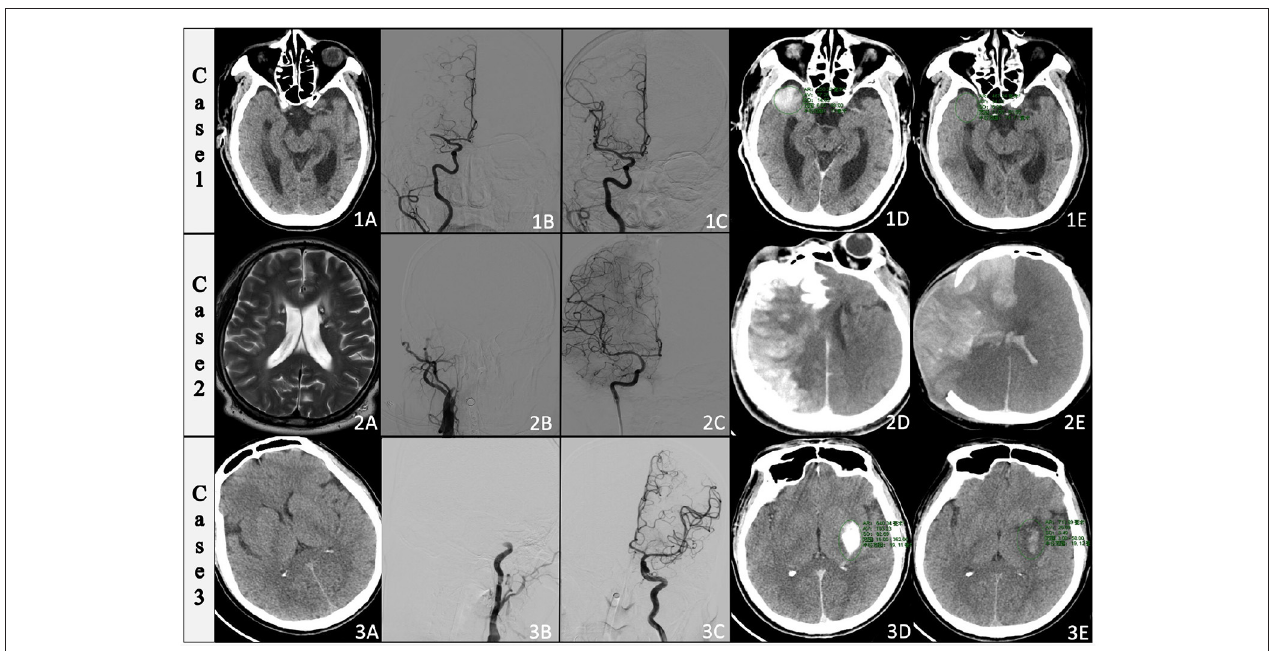
FIGURE 2 | Examples of HALs in patients with acute large vessel occlusion in anterior circulation. CASE-1 demonstrates extravasation of iodine: (1A) Head CT before ET, (1B) DSA showed right M1-segment occlusion that was successfully recanalized (1C) . On immediate CT (1D) , there were HALs in the right temporal lobe and the highest CT value was 89 HU. The HALs on follow-up CT performed at 24h after thrombectomy (1E) had vanished. CASE-2 shows IH after thrombectomy: (2A) Head CT before ET and DSA demonstrated right proximal internal carotid artery occlusion (2B) that was recanalized after endovascular treatment (2C) . The immediate CT showed a large amount of HALs in the right hemisphere (2D) . We measured the highest CT value in the HALs territory to be 413 HU. The follow-up CT showed hemorrhage in the right cerebral hemisphere on the 3 days (2E) . CASE-3 shows minor IH after thrombectomy: (3A) Head CT before ET and DSA showed distal occlusion of the internal carotid artery (3B) and was successfully recanalized (3C) . The immediate CT (3D) showed HALs in the left ganglia with the highest CT value of 362 HU. The hemorrhage showed in the follow-up CT (3E) was examined at